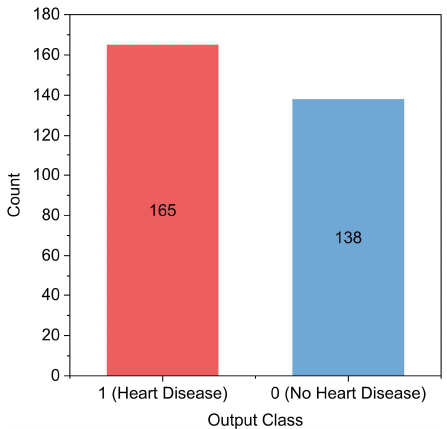
Figure 2. Cleveland dataset target classes.